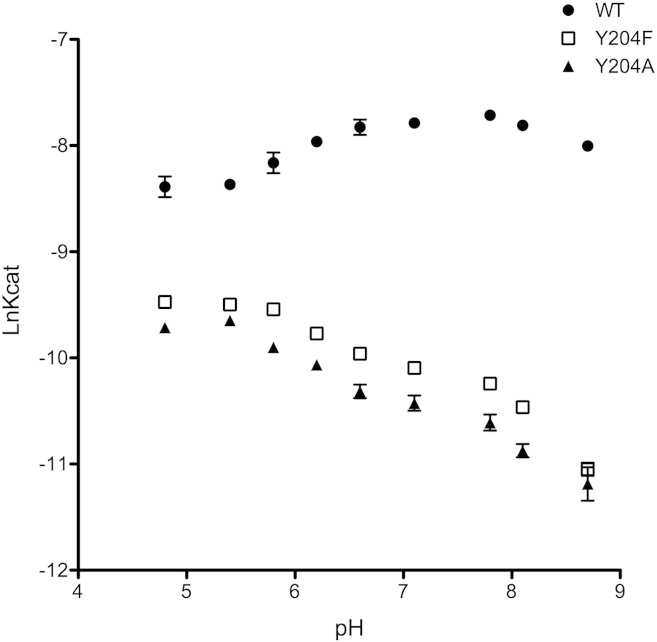
Optimal catalytic activity of wtFPPS and Tyr204 FPPS mutants is observed in different pH environment. The catalytic profile of wtFPPS is a bell shape curve with optimal catalysis observed at pH values between 6 to 8. Optimal catalysis in Y204F and Y204A FPPS mutants is observed in an acidic environment. Graph represents means obtained from four individual experiments.